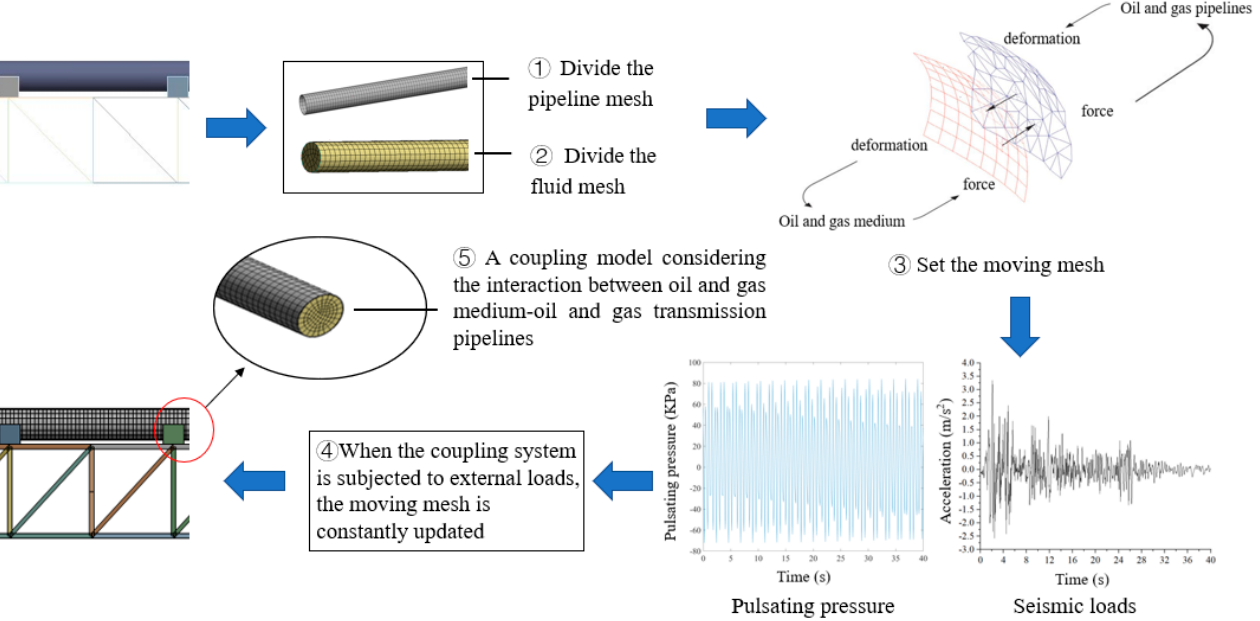
Figure 5. Finite element model of oil transmission pipeline calculation based on fluid–solid coupling.